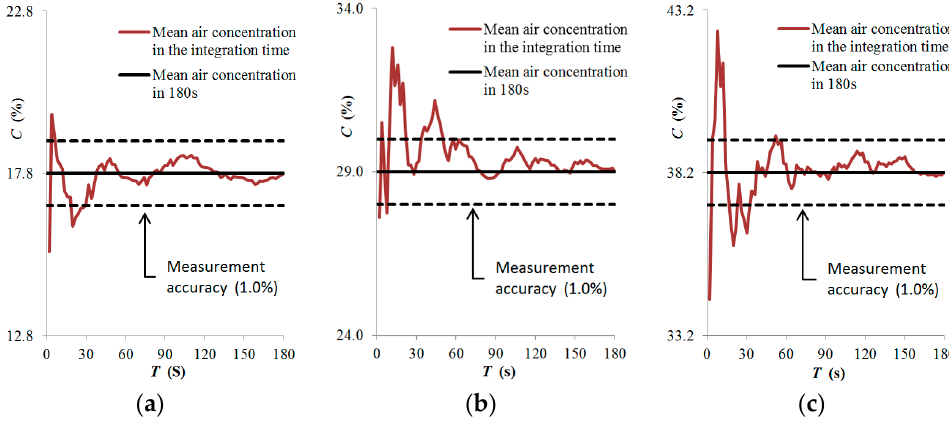
Figure 2. The uncertainty of air concentration measurements in the plunge pool.